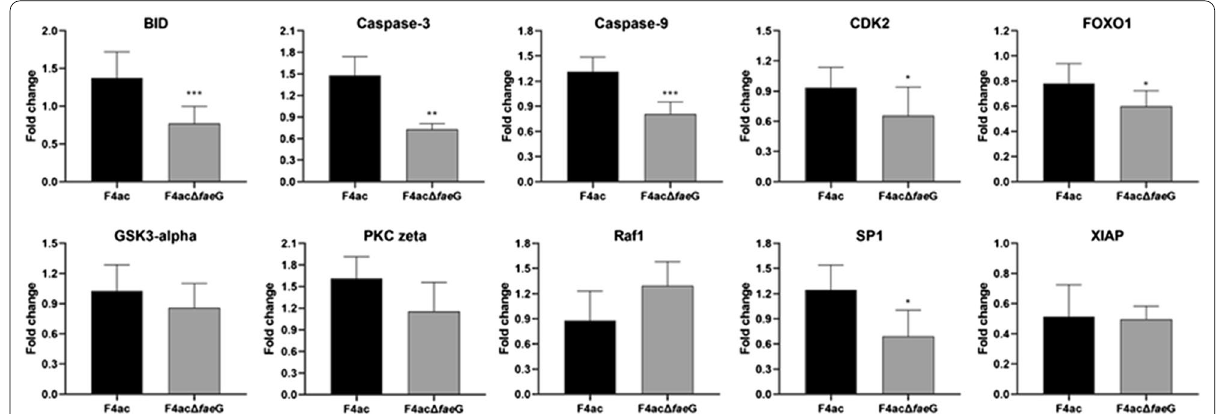
standard deviations of three ±